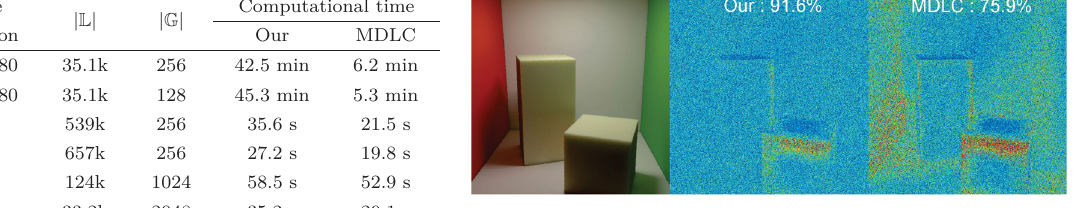
Fig. 7 Cornell box scene with two boxes of translucent